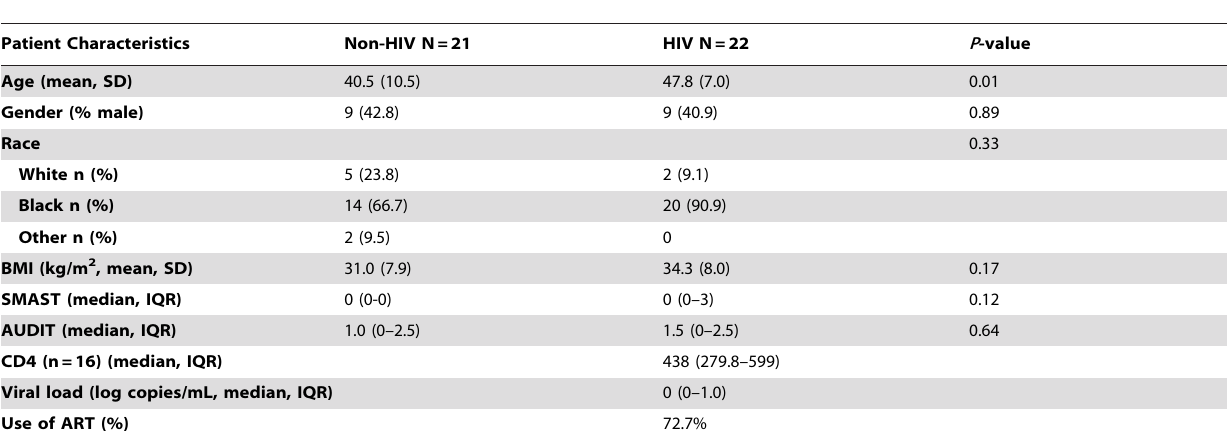
Table 1. Demographic characteristics of HIV-infected Subjects and Non-HIV-infected Subjects Enrolled in the Study.